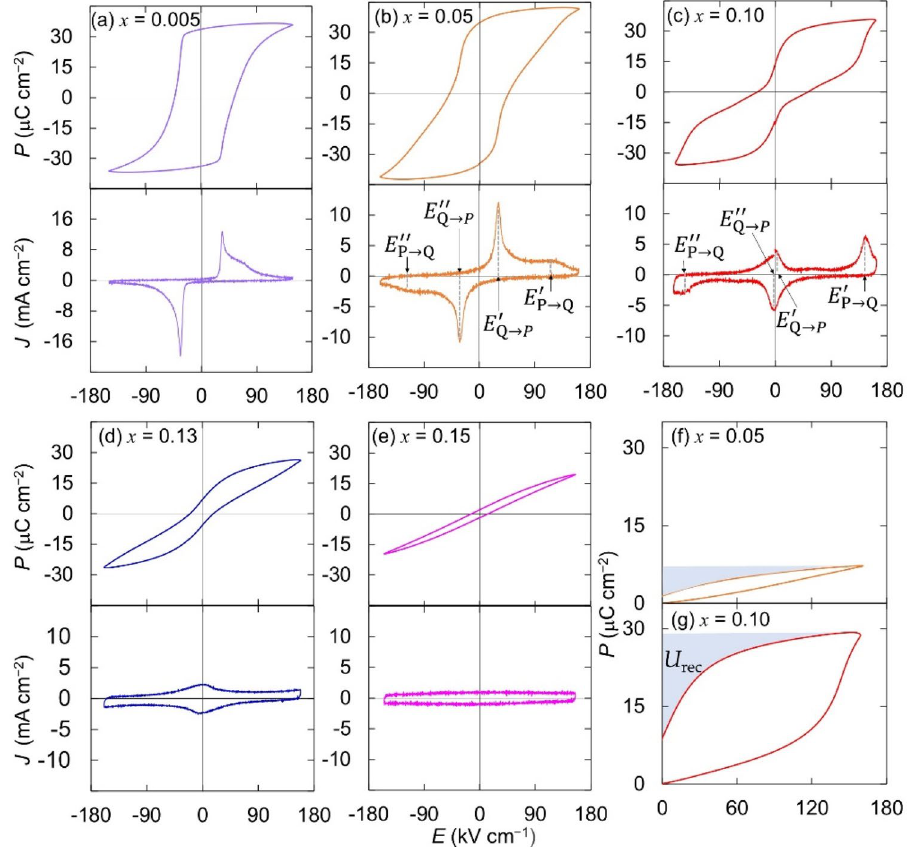
Figure 5. Bipolar P - E and J - E hysteresis loops of the Ca-modified samples (Ca x Na 1−2 x V x )NbO 3 : ( a ) x = 0.005, ( b ) x = 0.05, ( c ) x = 0.10, ( d ) x = 0.13, ( e ) x = 0.15. Unipolar P - E hysteresis loops at 1 Hz of ( f ) x = 0.05 and ( g ) x = 0.10.